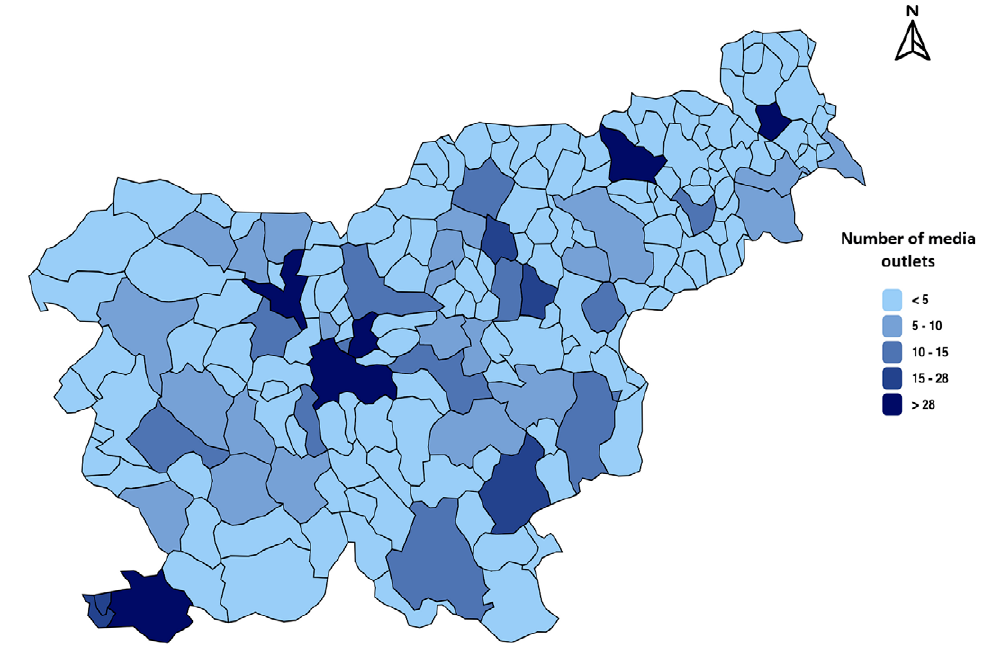
Figure 3. Number of media outlets in local self-governments in Slovenia